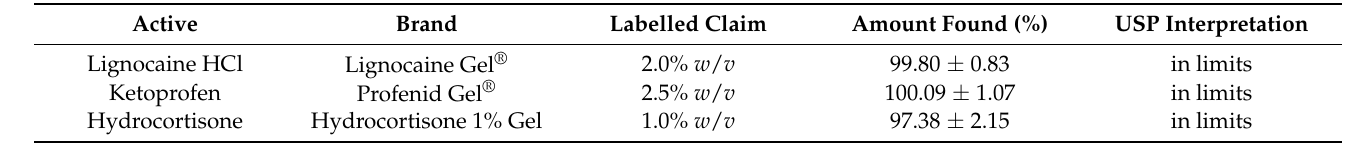
Table 6. Assay of commercial tablets according to the developed method.